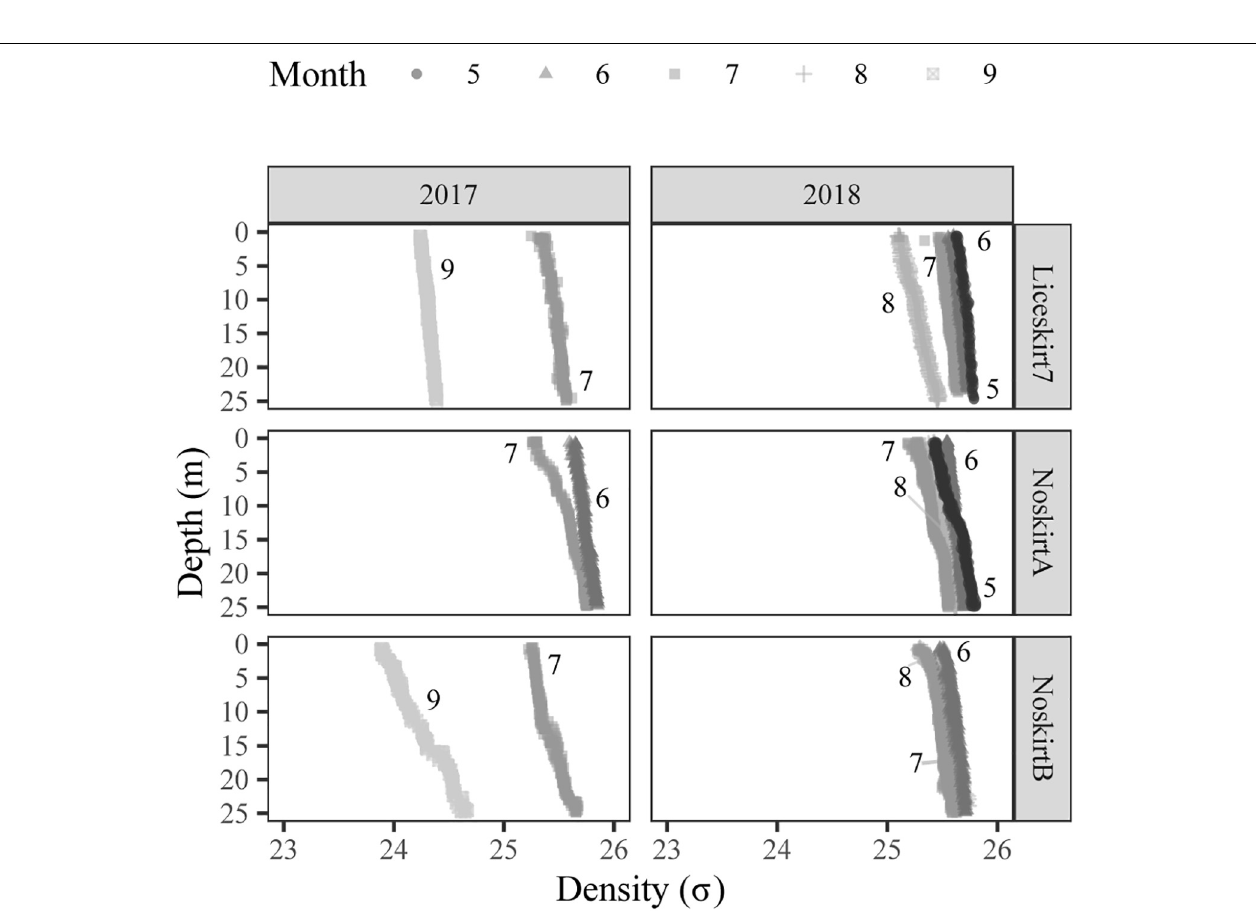
FIGURE 4 | Density ( σ ) profiles of the seawater with depth (m) at the time of sampling for each sample site. Shade and symbol illustrate which month the profile was taken from, in addition the number of the month is given next to the profile.